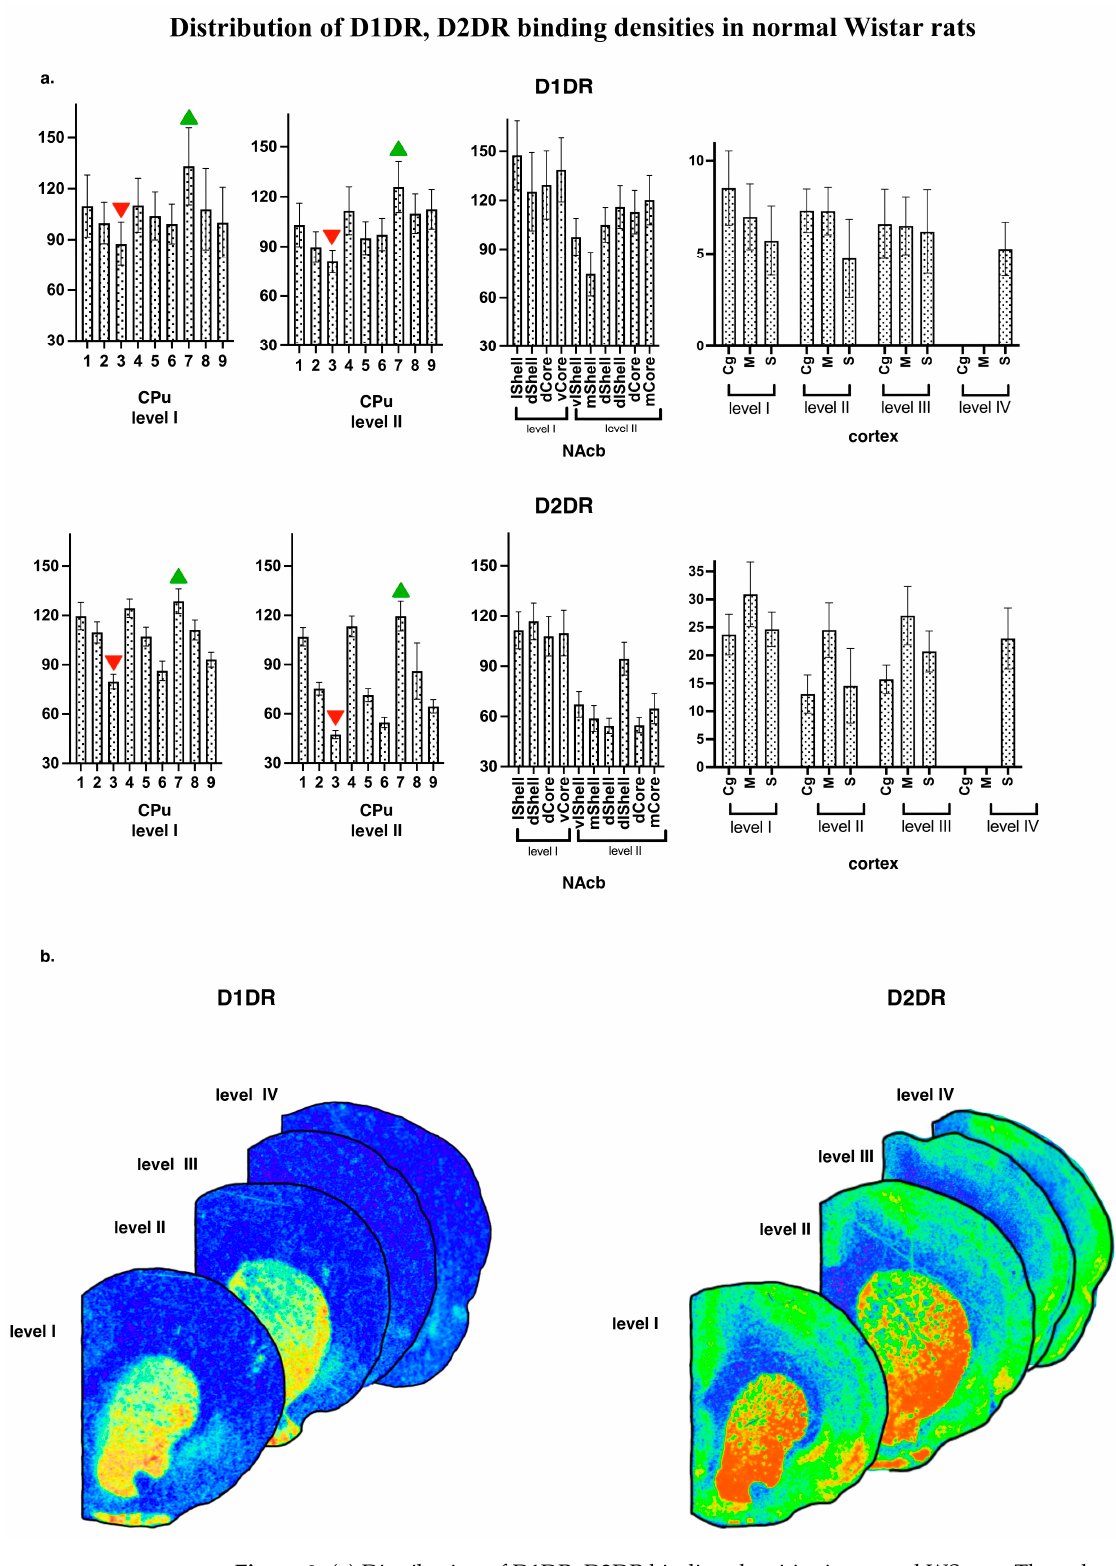
Figure 3. ( a ) Distribution of D1DR, D2DR binding densities in normal WS rats. The values are given as mean ± SEM, in pmol/g of tissue. CPu—caudate putamen; NAcb—nucleus accumbens. For other abbreviations, see Figure 2. ( b ) Examples of the autoradiographic images of [3H]spiperone binding densities in coronal sections of WS rat brain at the following anatomical levels: +2.4; +1.68; − 1.08; − 2.16 regarding bregma for D2DR and +2.28; +1.8; − 0.96; − 1.92 for D1DR.